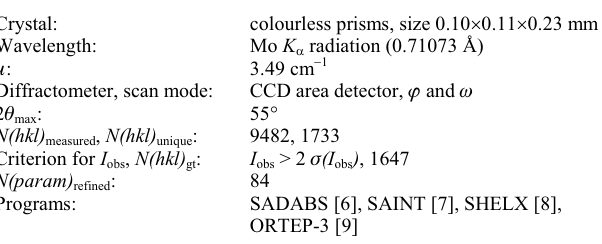
Table 2. Atomic coordinates and displacement parameters (in Å 2 )